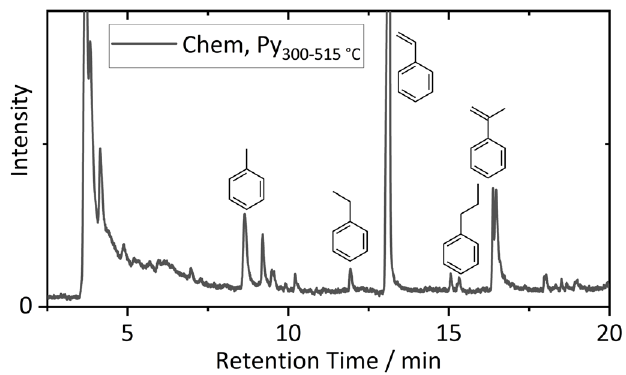
Figure 9. Magnified Py-GC-MS pyrogram (515 °C pyrolysis temperature) of the BM after chemical pretreatment (0.5 M; pH =3). Characteristic SBR-originating aromatic compounds, such as styrene, are marked.